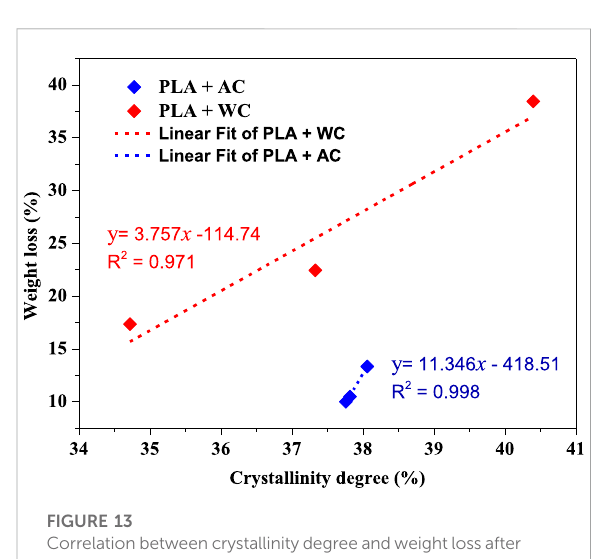
FIGURE 13 Correlation betweencrystallinitydegreeandweightlossafter 1 year of soil burial